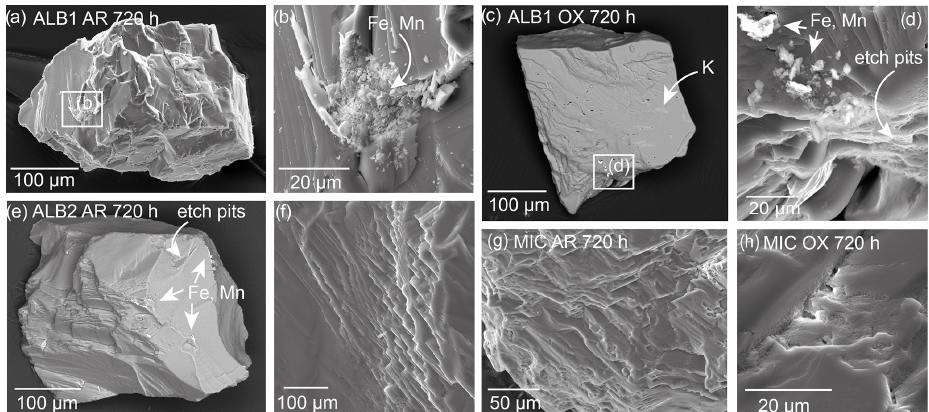
Figure 2. Scanning electron microscope (SEM) images after chemical treatment using aqua regia (AR) and oxalic acid (OX) for 720h of samples (a–d) ALB1, (e–f) ALB2, and (g–h) MIC. While panel (c) was detected with a BSE detector, all SEM images were detected with an SE detector using 20kV HV and ∼ 21mm